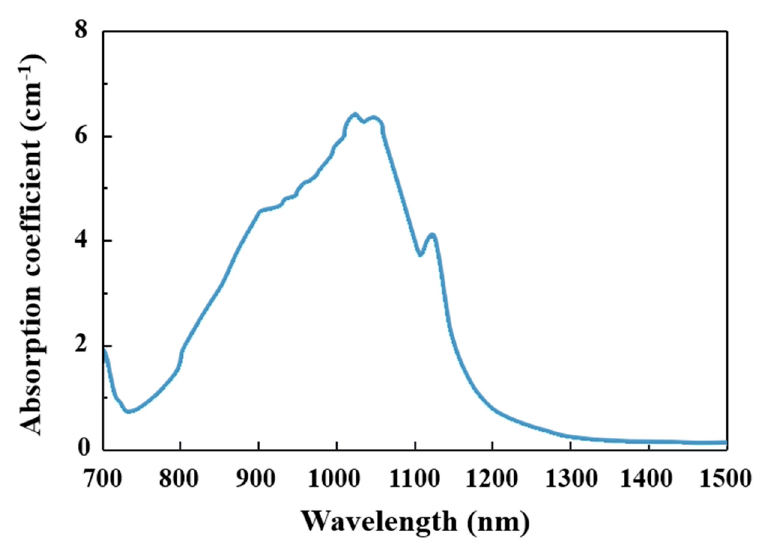
Figure 1. Absorption spectrum of Cr 4+ :YAG.